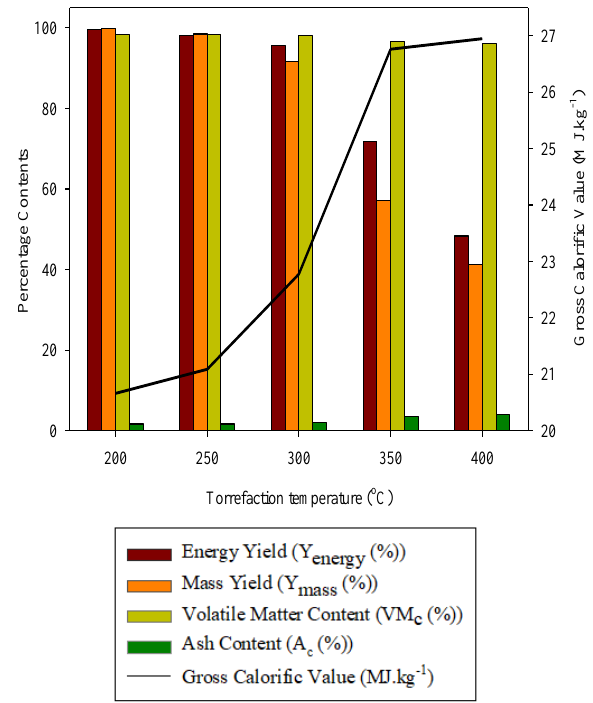
Figure 3. Effect of torrefaction temperature on Energy Yield (Y energy (%)), Mass Yield (Y mass (%)), Volatile Matter (VM c (%)), Ash Content (A c (%)) and Gross Calorific Value (GCV